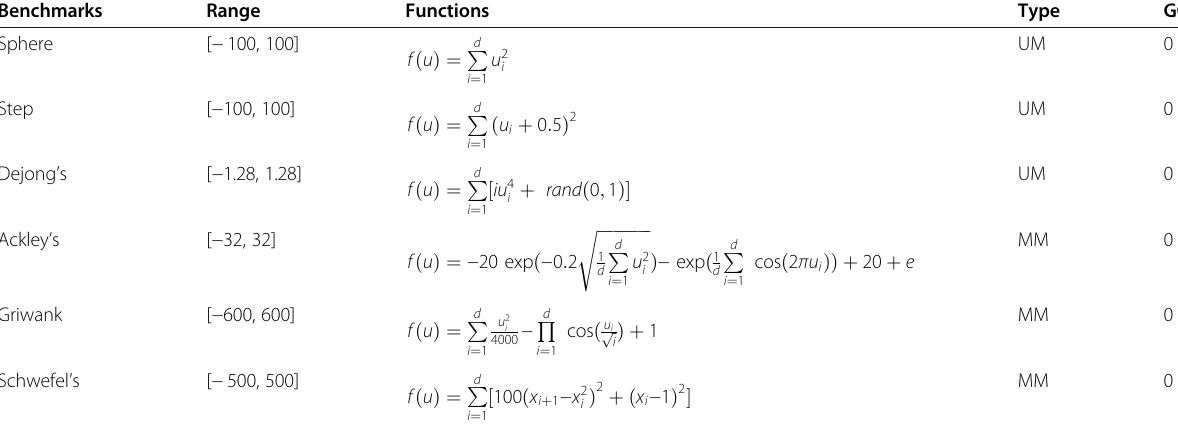
Table 3 Details of benchmark-test-functions [39]